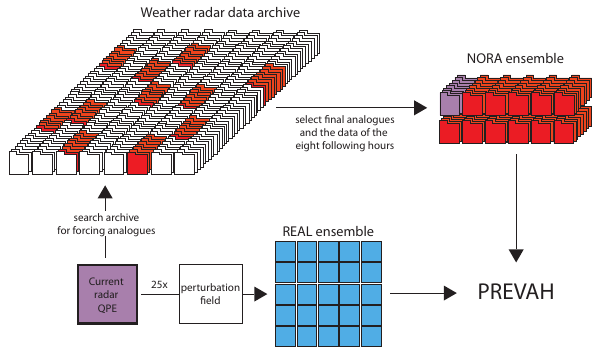
Fig. 2. Procedure to build the ensembles REAL and NORA. For the REAL ensemble, the current radar QPE is perturbed by a perturba- tion field 25 times to build an ensemble of 25 members. To build the NORA ensemble, a radar data archive is searched to find the situa- tions most similar to the current radar QPE. Then those analogues and the data of the eight hours following each forcing analogue are extracted from the archive, and an ensemble of 12 members with 8h lead time each is